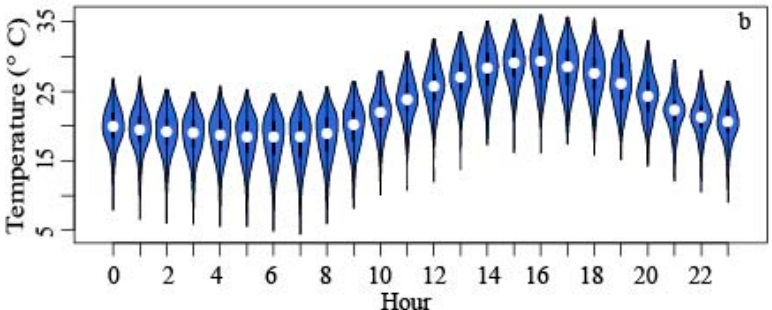
Figure 2. Hourly temperature distributions for Downtown ( a ) and Ijams ( b ) during the study period, including hour of the day and temperature.